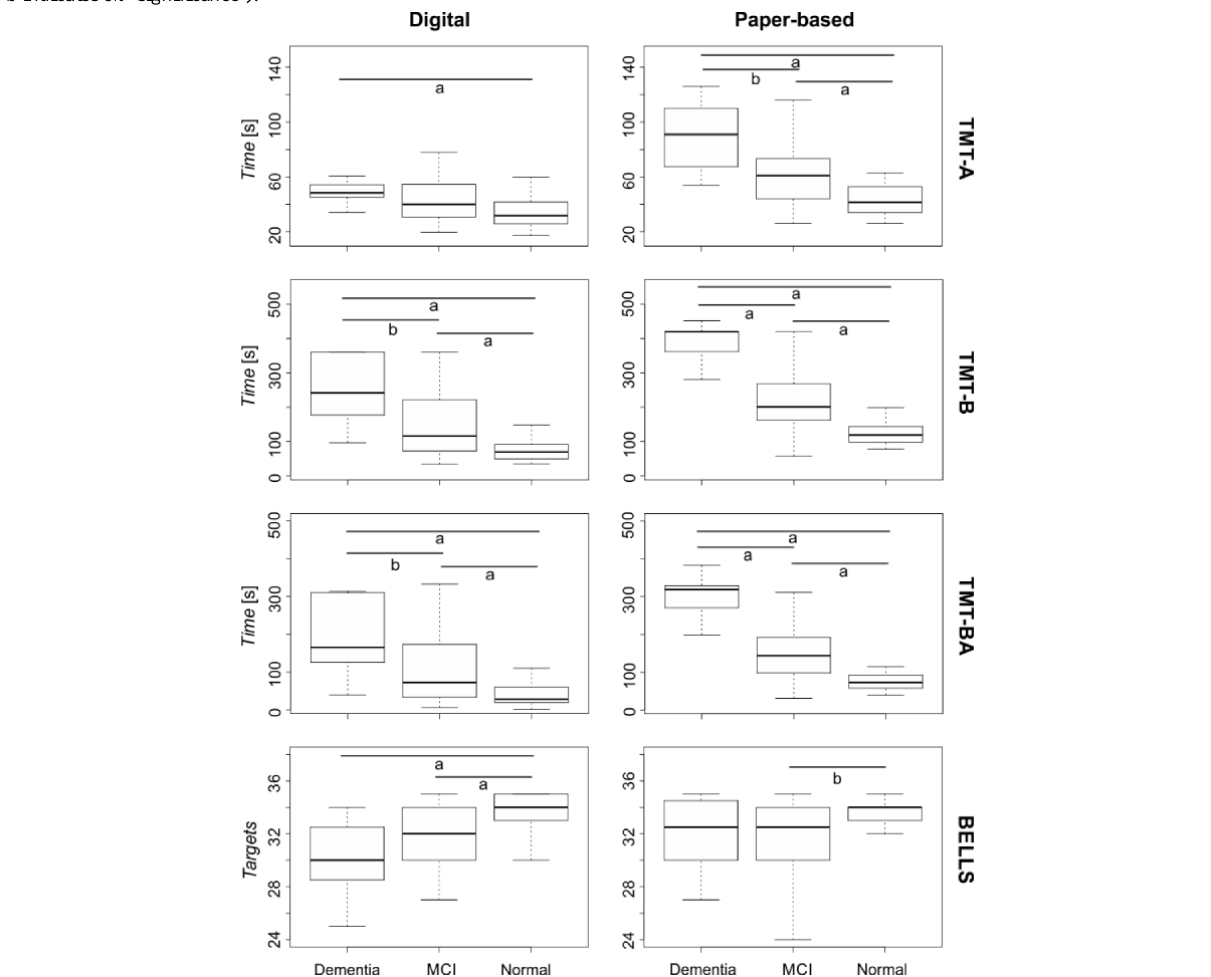
Figure 4. Differences in test scores based on the participant’s neuropsychological diagnosis. The boxplots represent, for the 3 neuropsychological diagnosis groups (normal, mild cognitive impairment, and dementia), the main outcome of the tests (time for Trail Making Test [TMT]-Part A, TMT-B, and TMT-BA and targets for Bells Test) as median and IQRs. Asterisks indicate significance from pairwise comparison (a indicates 1% significance and b indicates 5% significance